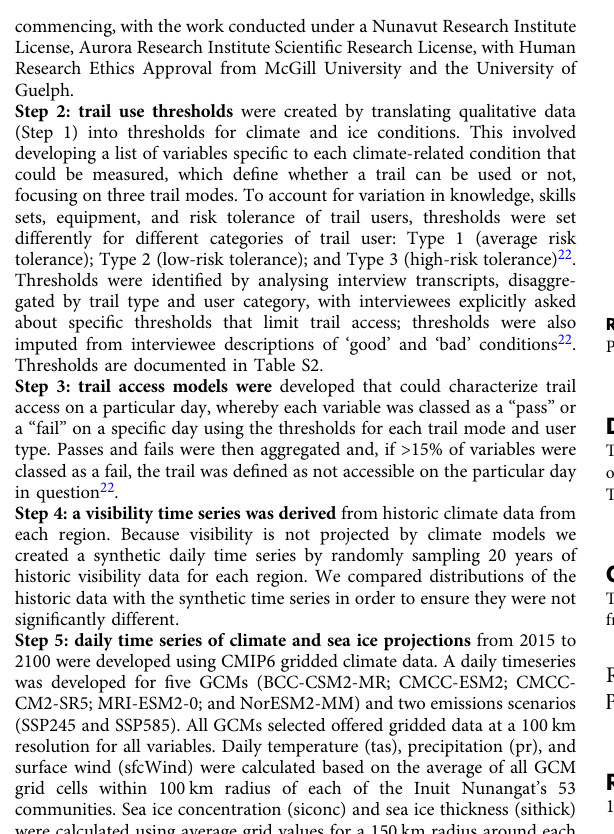
Fig. 8 Steps used in the modelling framework. The framework is composed of 7 steps, beginning by identifying and characterising climatic conditions that matter for trail